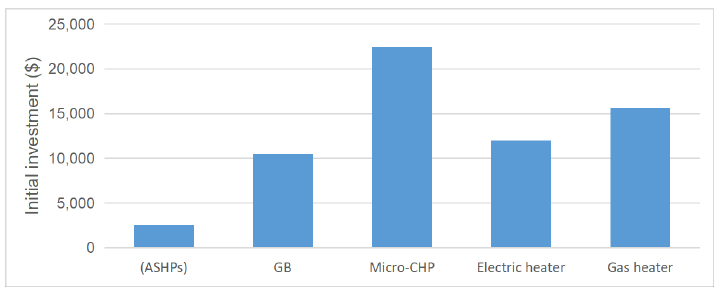
Figure 2. The investment of different DHW